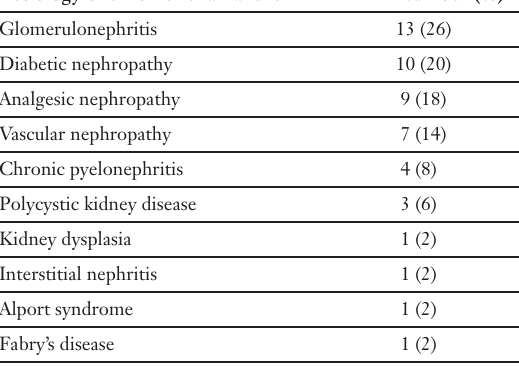
Table 1 Basic renal disease